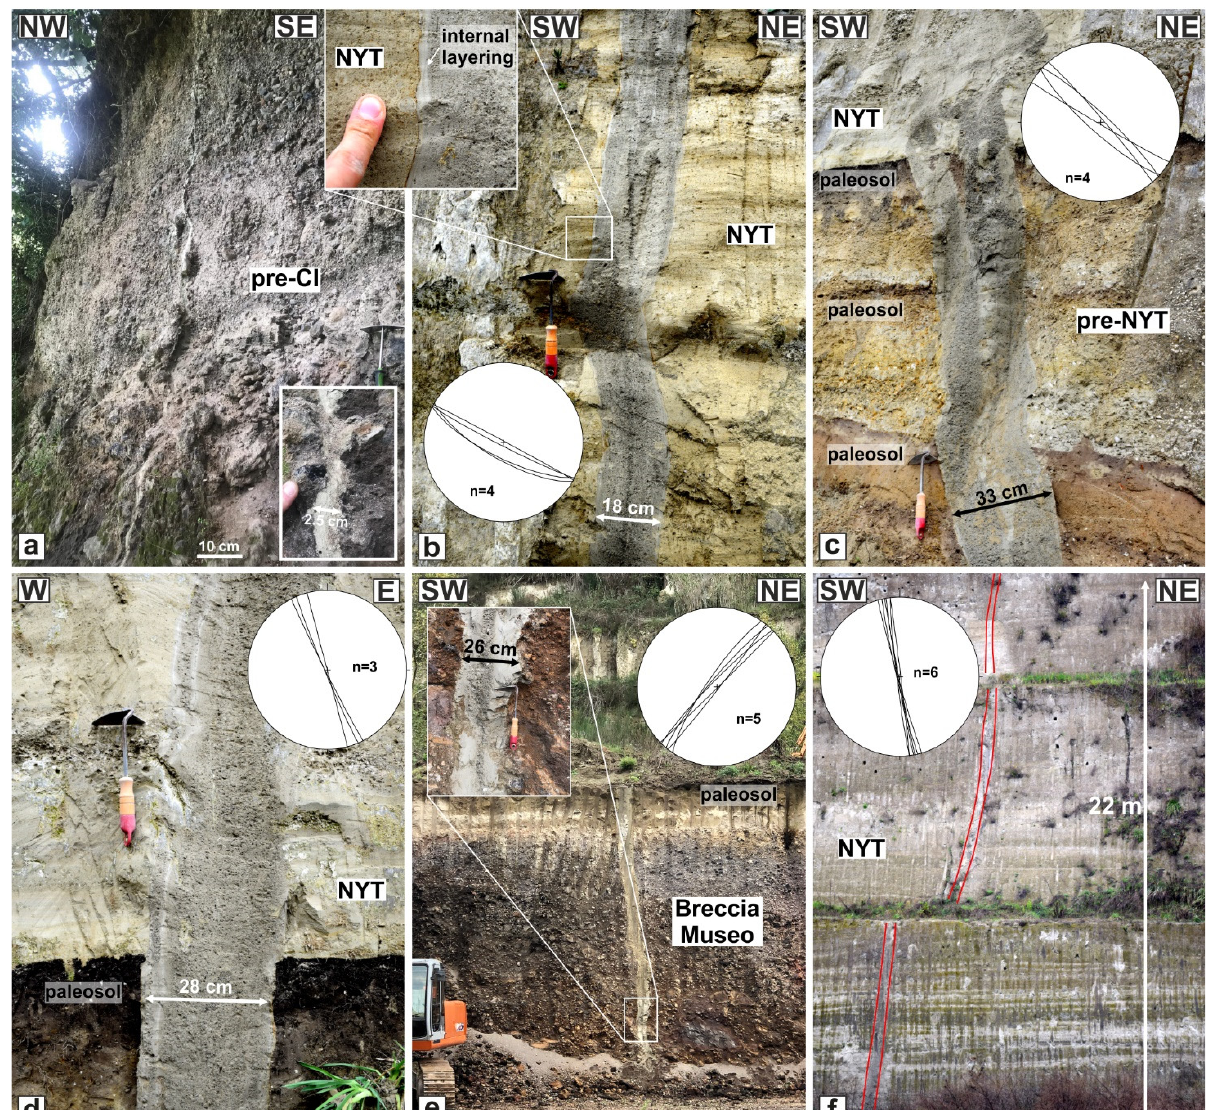
Figure 6. Punta Marmolite (site 6): ( a ) sand dike within the breccia deposit of the Punta Marmolite lava dome. Zaccaria quarry (site 7): ( b – d ) sand dikes within the pre-NYT and NYT tephra layers; ( e ) sand dike cross-cutting the Breccia Museo Unit of the Campanian Ignimbrite deposit; ( f ) sand dike hosted in the NYT with a length larger than 22 m. Stereographic projections of dike boundaries are shown in ( b – f ).